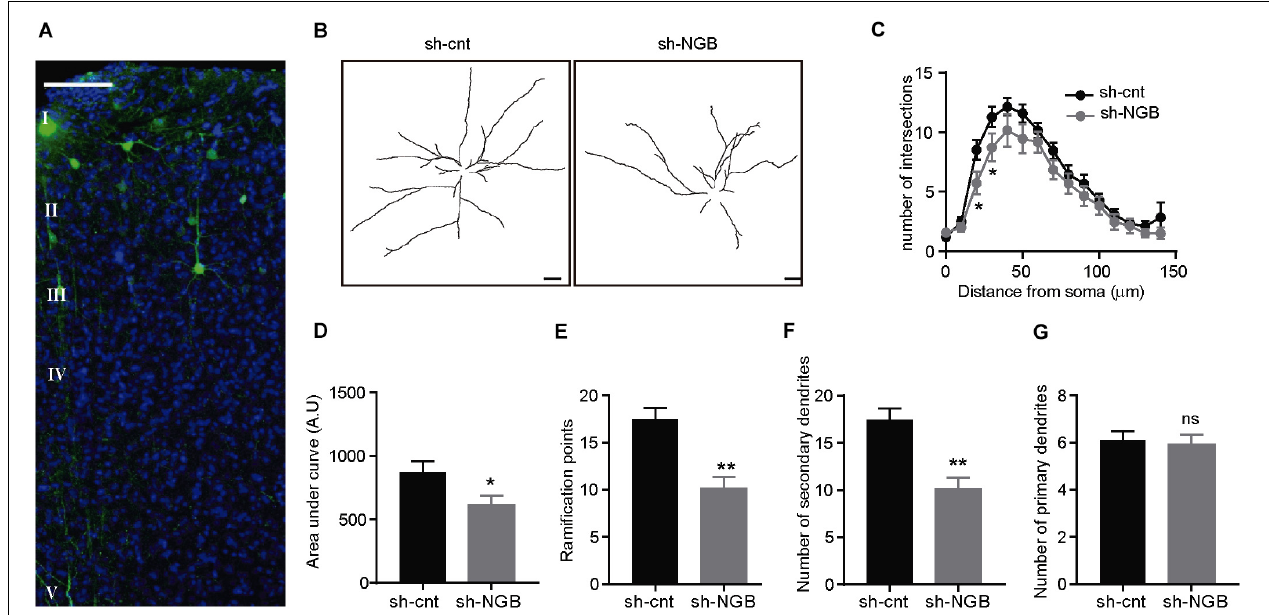
FIGURE 5 | Ngb downregulation reduces the dendritic complexity of cortical pyramidal neurons in old APP NL/F mice. (A) Confocal image representative of the area infected with a lentivirus expressing an shRNA against Ngb and turboGFP (tGFP) (sh-Ngb). Nuclei are stained with DAPI and cortical layers are indicated. (B) Representative traces of the dendritic arborization of cortical neurons of the layer III infected with a control lentivirus (sh-cnt) or sh-Ngb to downregulate Ngb. (Scale bar: 20 µ m). (C) Sholl analysis to determine the dendritic complexity of neurons infected with a control (sh-cnt; n = 17 sh-cnt neurons in total analyzed from 4 mice) or silencing (sh-Ngb; n = 17 sh-Ngb neurons in total analyzed from 4 mice) lentivirus ( n = 34 neurons in total from 8 mice * p < 0.05). Statistical significance was analyzed by one-way ANOVA followed by Tukey’s post hoc analysis. (D) Graph representing the area under the curve calculated from Panel C (* p < 0.05). The graph shows the mean ± SEM. Statistical significance was analyzed by t test. (E–G) Dendritic bifurcations (E) and higher-order dendritic branches (F) are less abundant in neurons infected with sh-Ngb, while no differences are observed for primary dendritic branches (** p < 0.01). The graphs show the mean ± SEM. Statistical significance was analyzed by one-way ANOVA followed by Tukey’s post hoc analysis (C) and t test (D–G) .